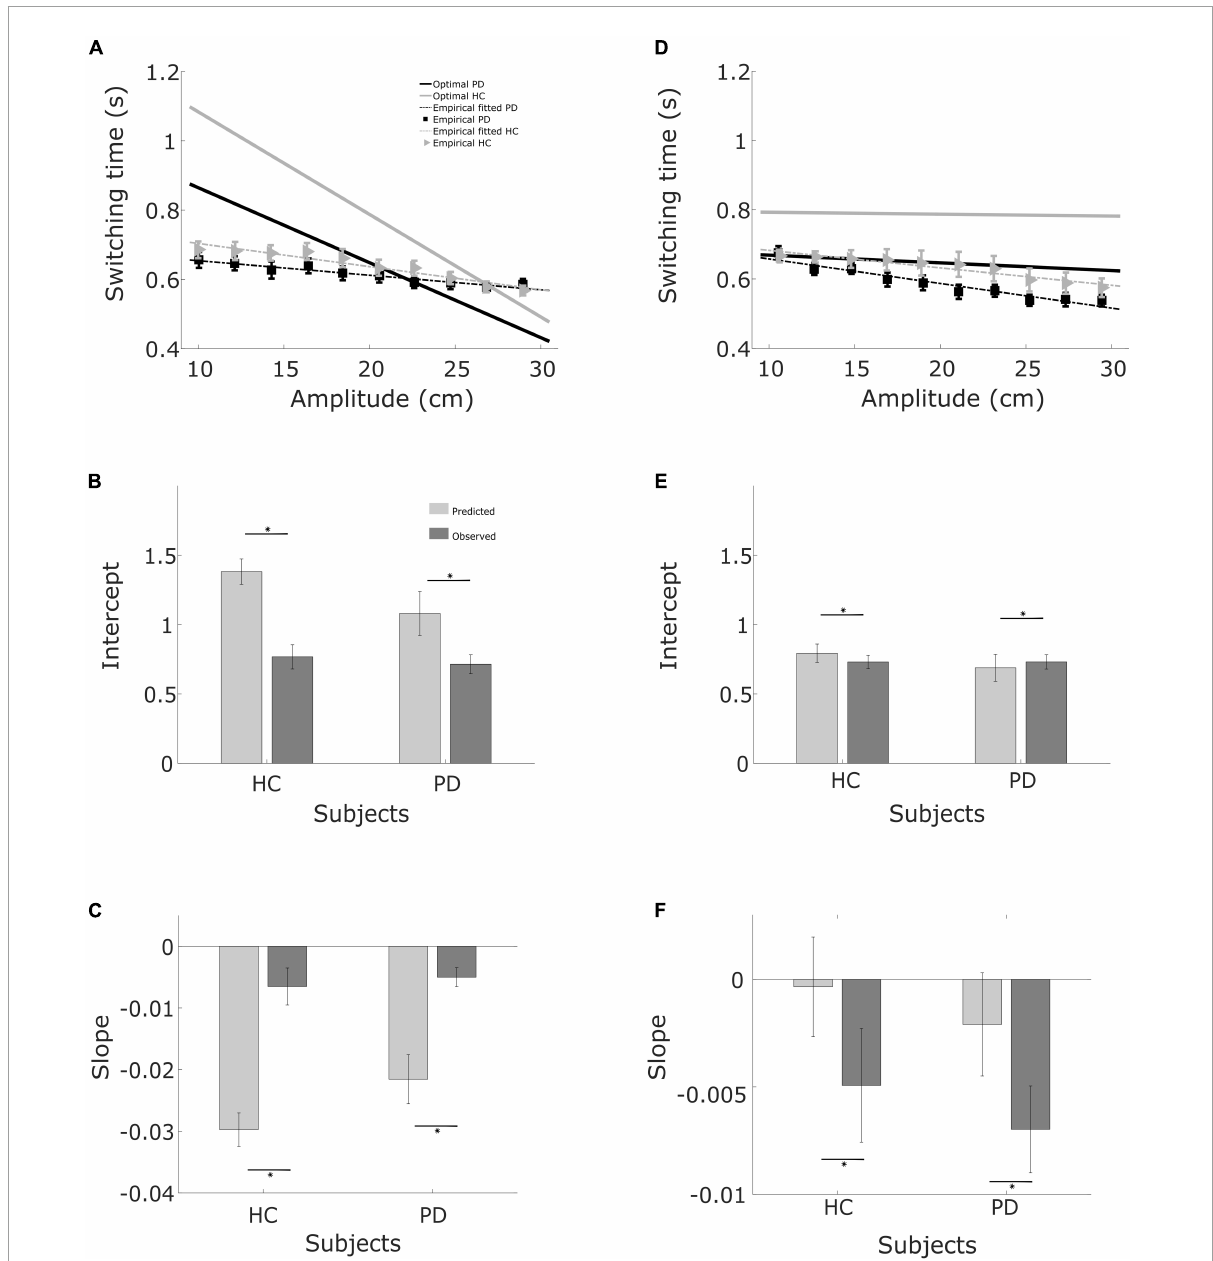
FIGURE6 Regression fits and bar graphs with the fit coefficients. (A) Relationship between required movement amplitude and switching time. Linear regression curves and optimal curves for balls starting from the left, in both PD patients and controls. (B) Intercept for balls starting from the left for controls and patients. (C) Slope for balls starting from the left for patients and controls. (D) Same as (A) , but for balls starting from the right. (E) Same as (B) for balls starting from the right. (F) Same as (C) , for balls starting from the